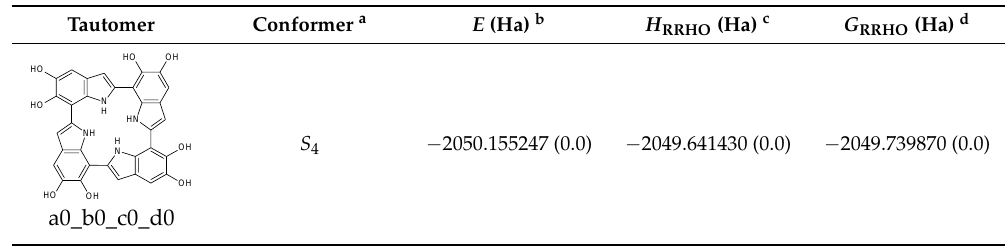
Table 1. KP-Red, neutral form in vacuo.